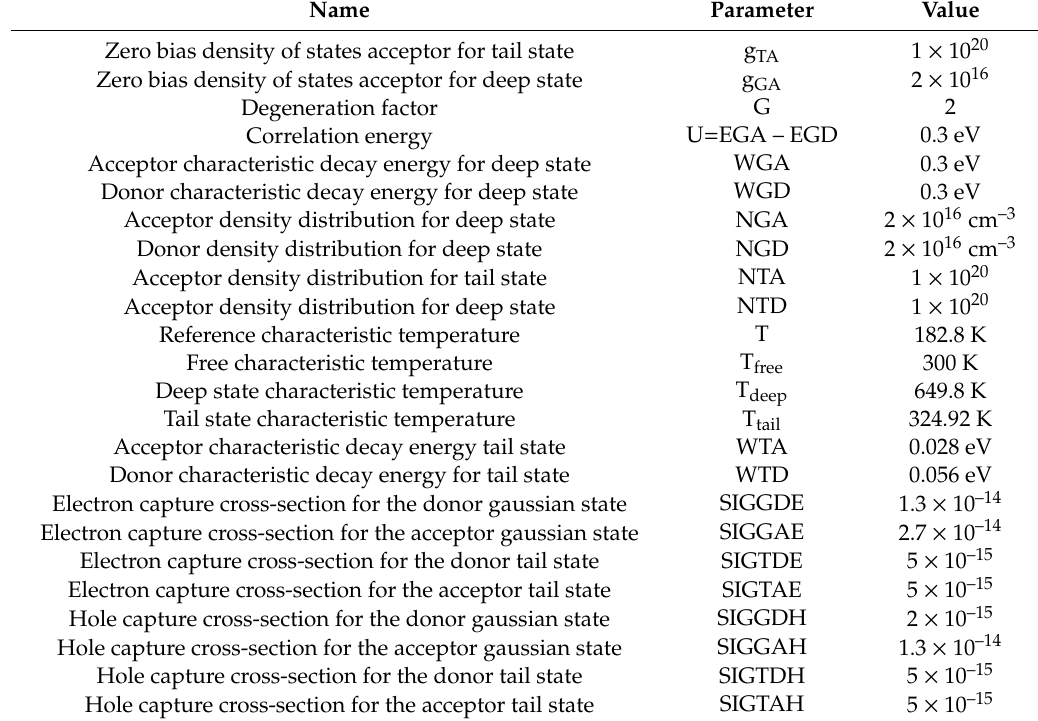
Table2. Defectsparametersofa-SiGe:Hlayeremployedinanalyticalmodelandnumericalsimulations[20].